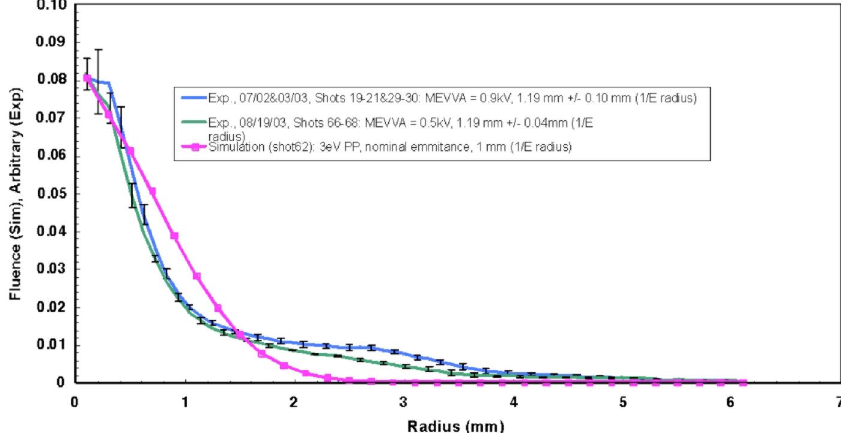
FIG. 42. (Color) Comparison of radial density profiles from two plasma-neutralized NTX shots with a theoretical profile (magenta) from an LSP simulation.